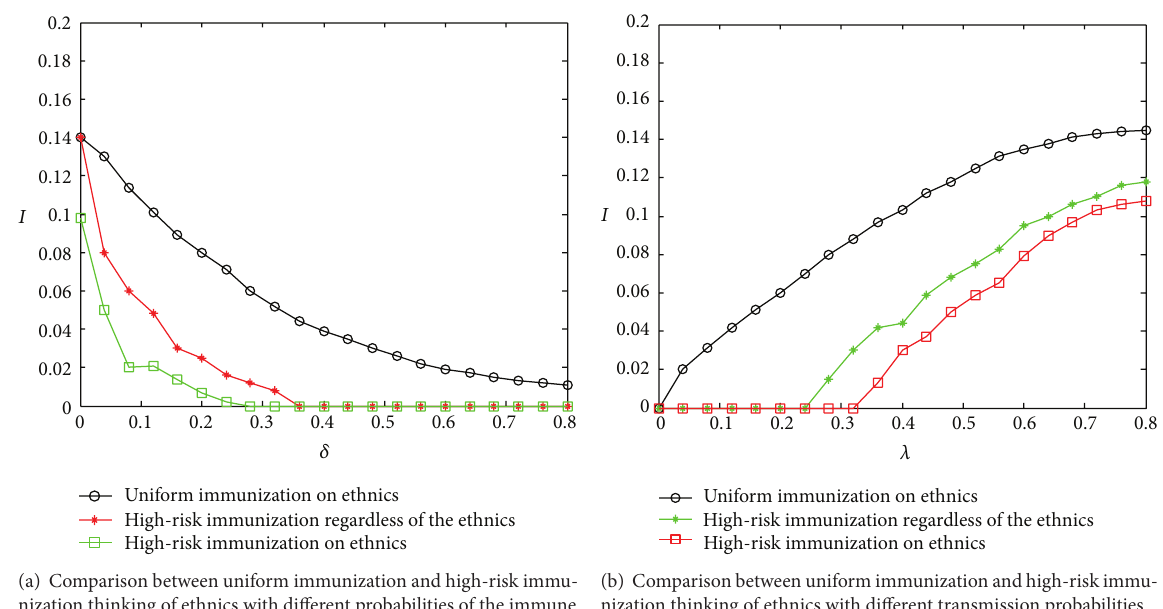
Figure 2: Computer simulations of SIRS model on BA scale-free networks ( 𝑁 = 2000, ⟨𝑘⟩ = 4 , 𝜁 𝐴𝐵 = 𝜁 𝐵𝐶 = 𝜁 𝐴𝐶 = 0.7 ). (a) At a fixed spreading rate 𝜆 = 0.3 , the changing of infected density 𝐼(𝛿) as a function of 𝛿 . (b) At a fixed vaccinating rate 𝛿 = 0.3 , the changing of infected density 𝐼(𝜆) as a function of 𝜆